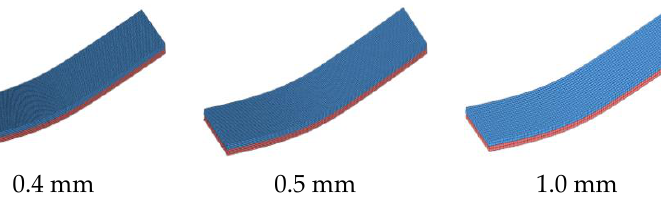
Figure 7. Model II with different element sizes.